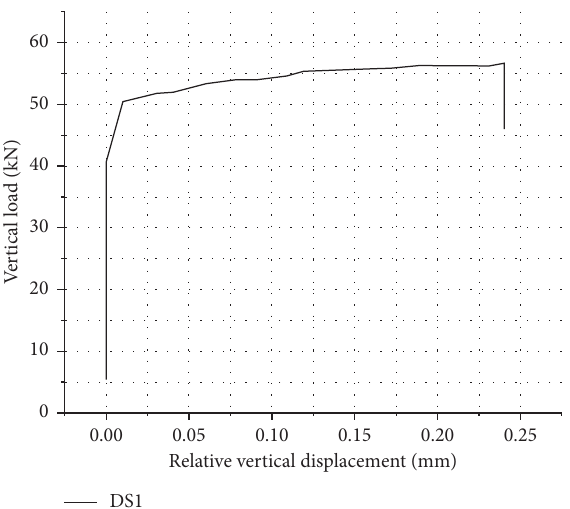
Figure 6: DS1 vertical load vs. relative vertical displacement.